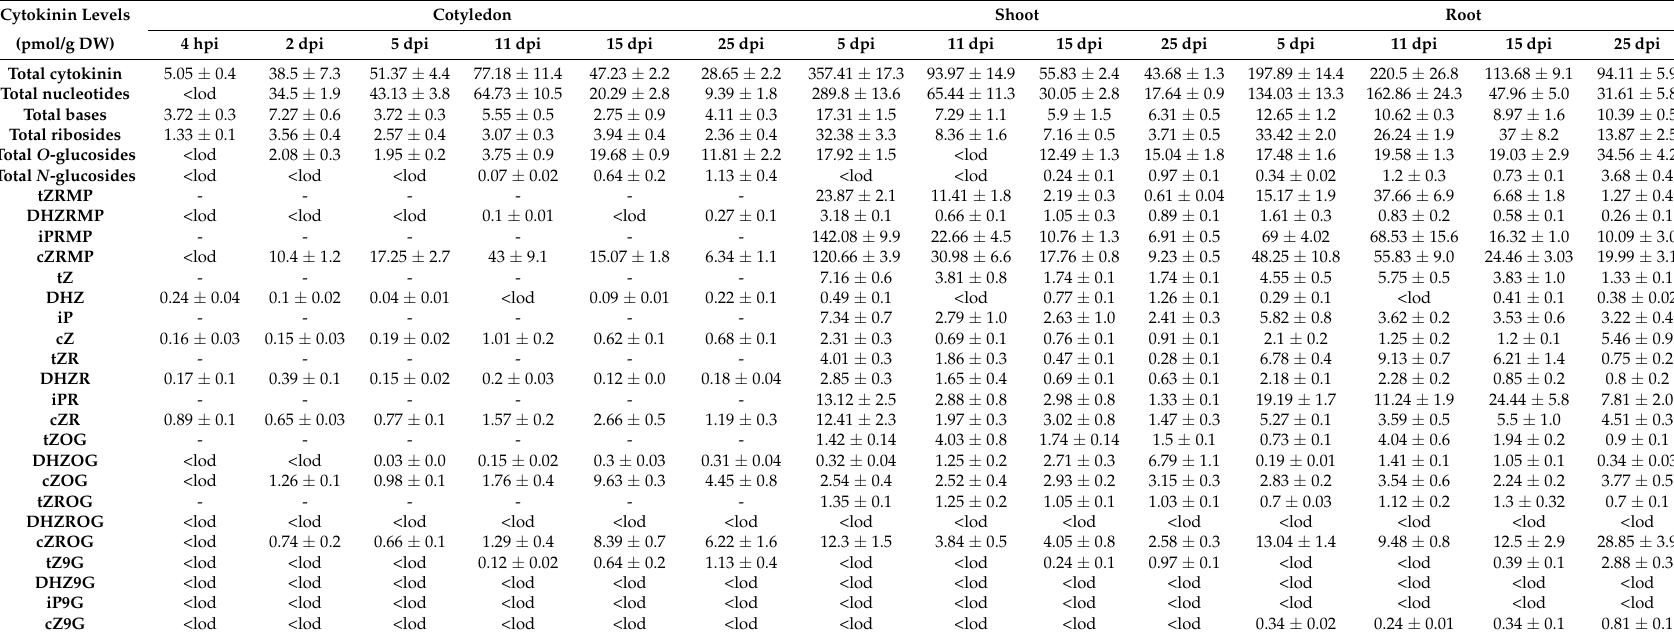
Table 1. Endogenous cytokinins in germinating pea seeds. The data are the averages of four biological replicates and are expressed as ± SD. Cytokinin